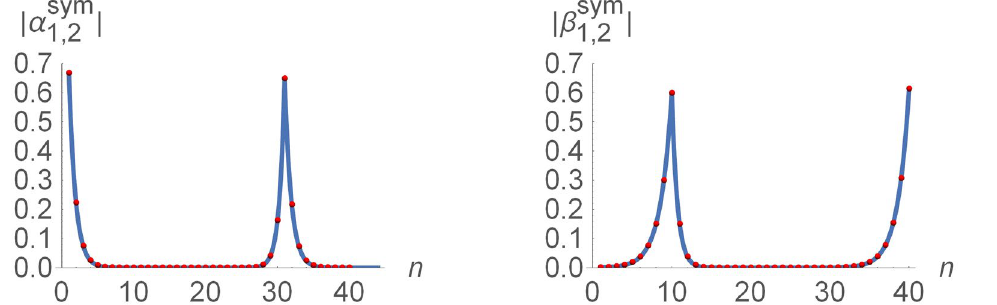
, λ 2 = 4, N 1 = N 2 = 10, and M = 20. 1 3